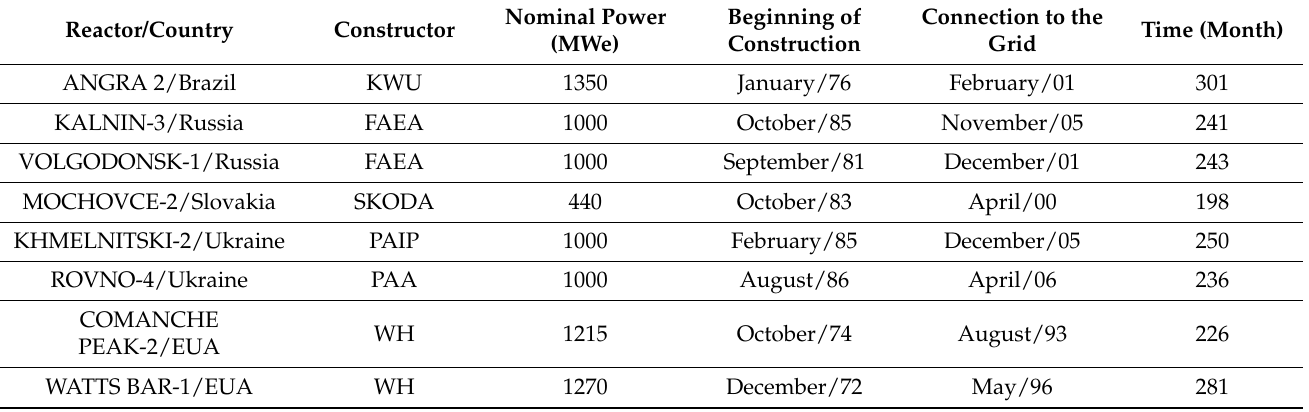
Table 1. Nuclear plants with excessive construction time. Source: authors according to IAEA